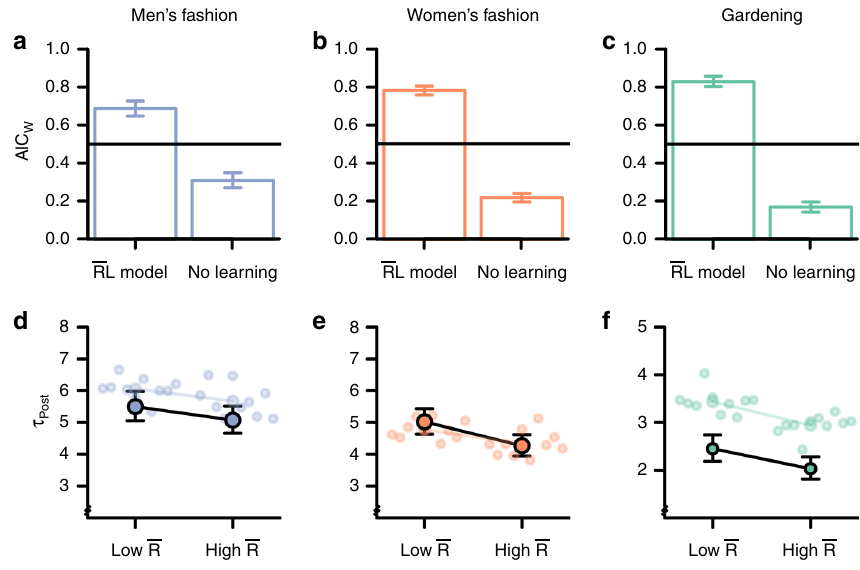
Fig. 3 Signatures of reward learning on three social media sites (Study 2). a – c Model comparison shows that the (cid:1) RL model explained behavior on the three social media sites (total N = 2,127 independent individuals. a N = 543, b N = 773, c N = 813) better than a model without learning. The AIC W expresses the relative likelihood for each model, and are presented as means + / − 99% CI. The horizontal line at 0.5 represents the chance level of no difference between models. The exceedance probability for the (cid:1) RL model was 1 in all three datasets. The distribution of AIC W is displayed in Supplementary Fig. 3. Source data are provided as a Source Data fi le. d – f The model derived estimate of (cid:1) R, the average reward rate, predicted the latency between posts on each social media platform ( d N = 543, e N = 773, f N = 813 independent individuals). In line with reward learning theory, the latency between posts was shorter with high compared to low (cid:1) R. The colored points indicate the corresponding estimates from simulated data, based on ten generative simulation runs of the (cid:1) RL model (see text for details). The colored lines show the average effect in the simulated data. Results are presented as means ( fi xed effects regression estimates) ± 99% CI from mixed-effects